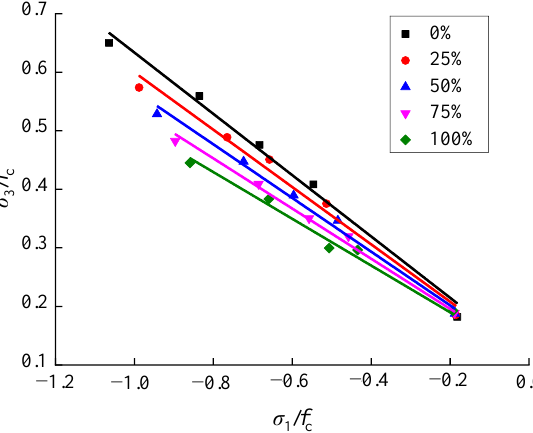
Figure 11. Compression–shear principal stress relationship of recycled concrete.